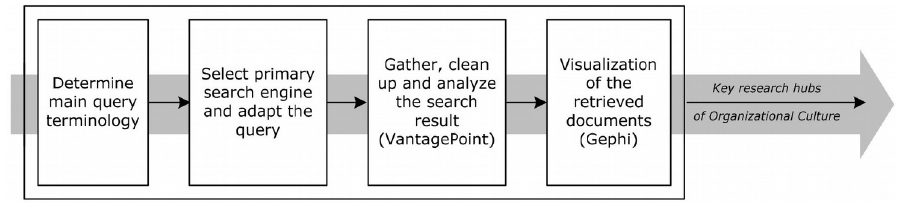
Figure 6. Workflow of Scientific Visualization process